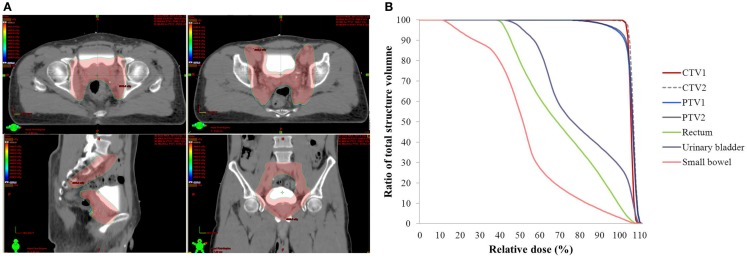
Isodose curves (A) and dose–volume histogram (B) of whole pelvis radiotherapy for the applied RapidArc plan in the particular patient. (A) The region of the prescription dose (45 Gy), pink color wash; CTV1, red solid line.